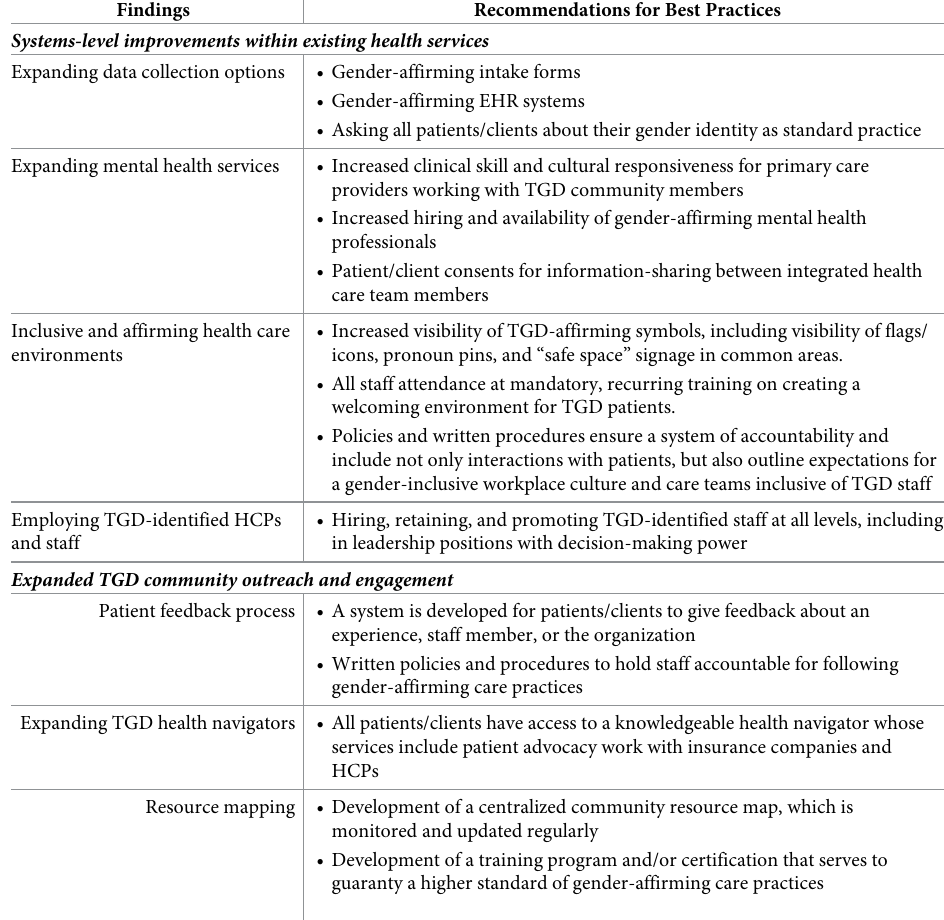
Table 4. Summary of findings and recommended best